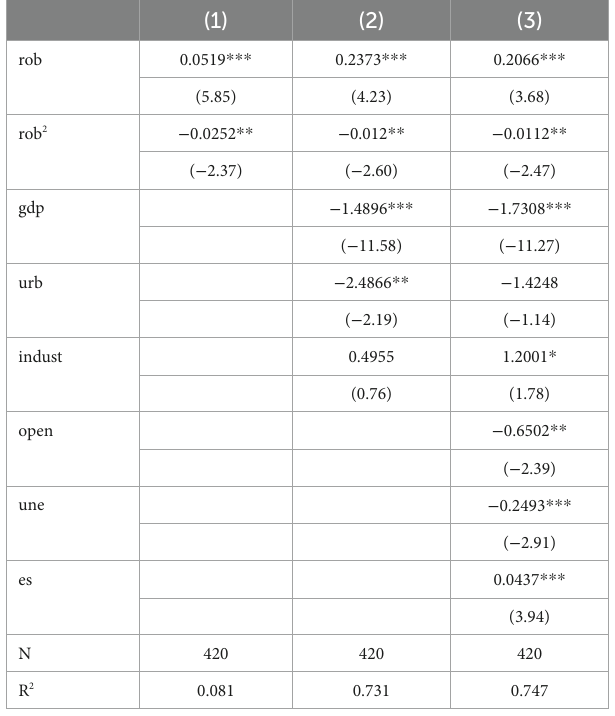
TABLE 2 Benchmark regression